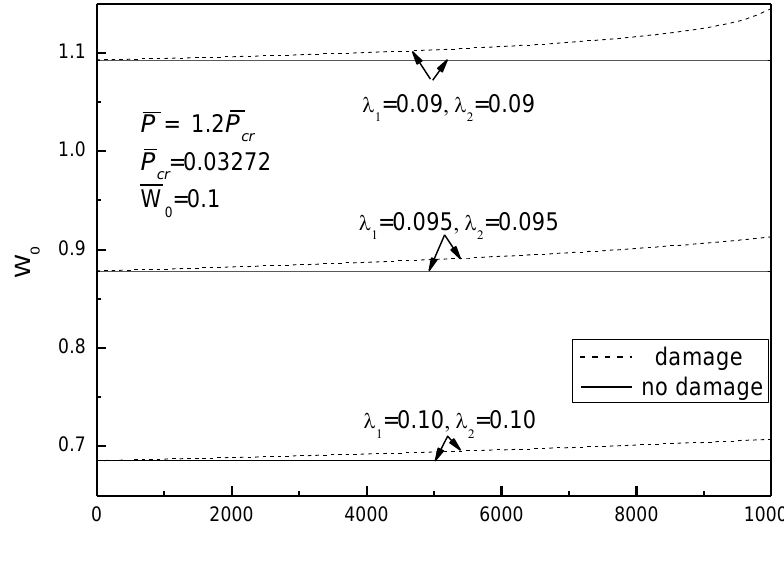
Figure 14. Effect of thick-span ratio on postbuckling response curves of piezoelectric plate with damage and initial